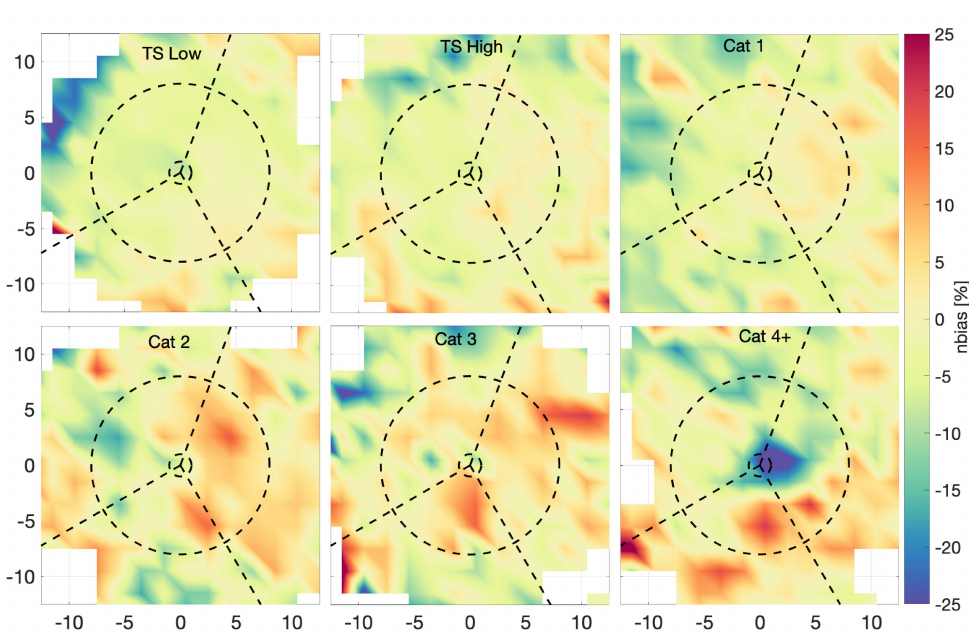
Figure 13. Each subplot as in Figure 12a for each category of the S-S intensity scale. (Note the difference in color scale.).